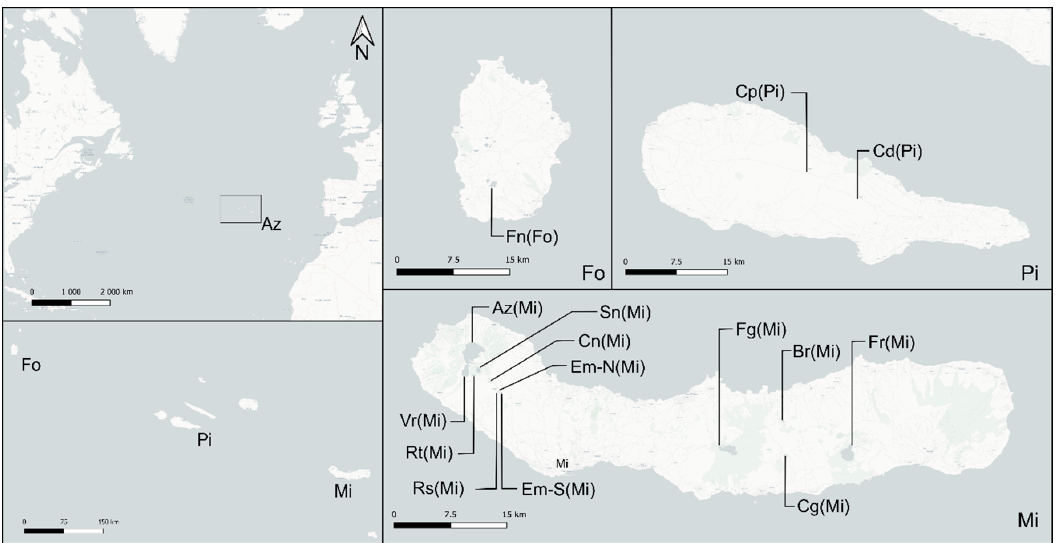
Table 1. Physical, chemical, and biological properties are presented as mean values, with standard deviation, of all campaigns. Latitude, longitude, altitude, and lake surface area data were retrieved from Pereira et al. [50].